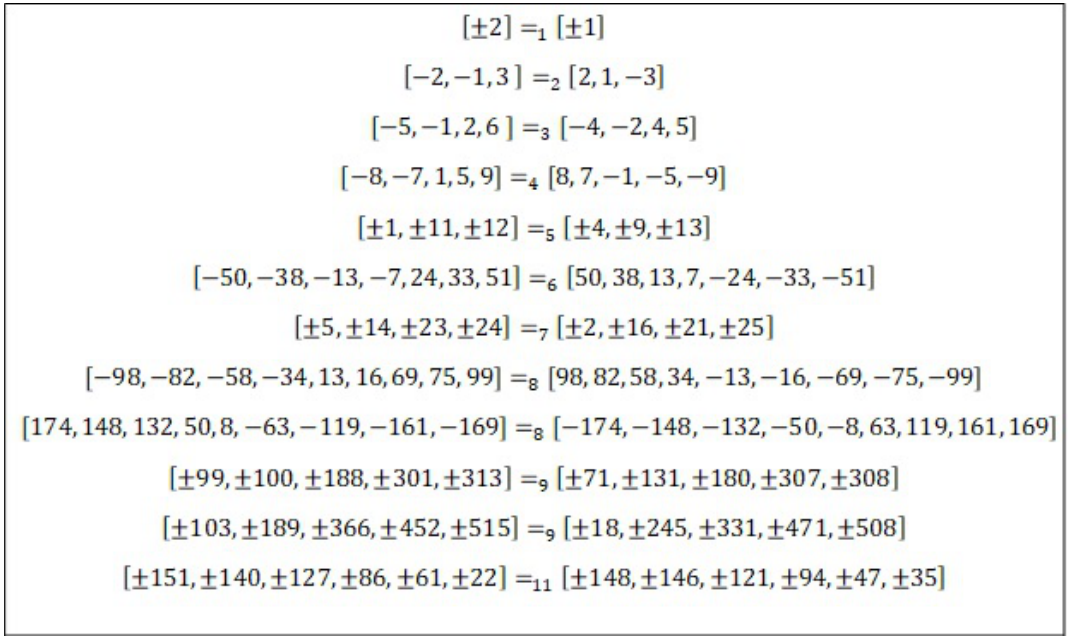
Figure 1. List of the smallest known ideal solutions of size upto 12, as in Reference